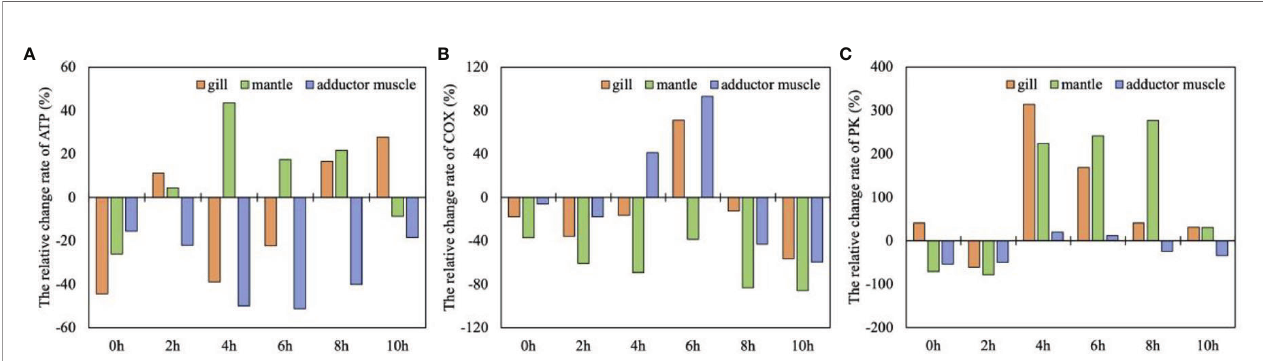
FIGURE 6 | The relative change rate of metabolic indexes [ (A) ATP; (B) COX; (C) PK] of gill, mantle and adductor muscle under severe hypoxia (2mg/L DO) condition (means, n = 5).